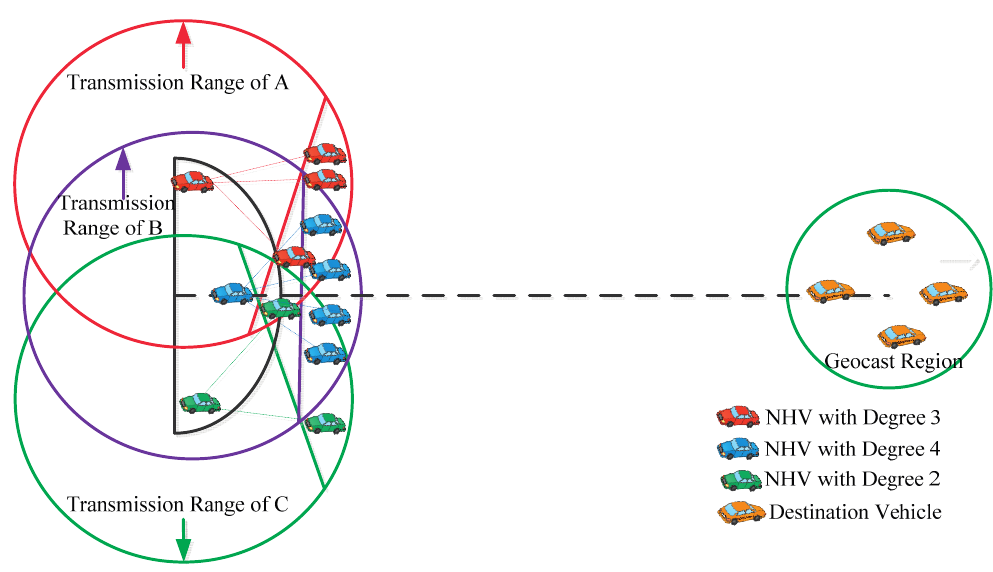
Figure 6. NHV selection based on